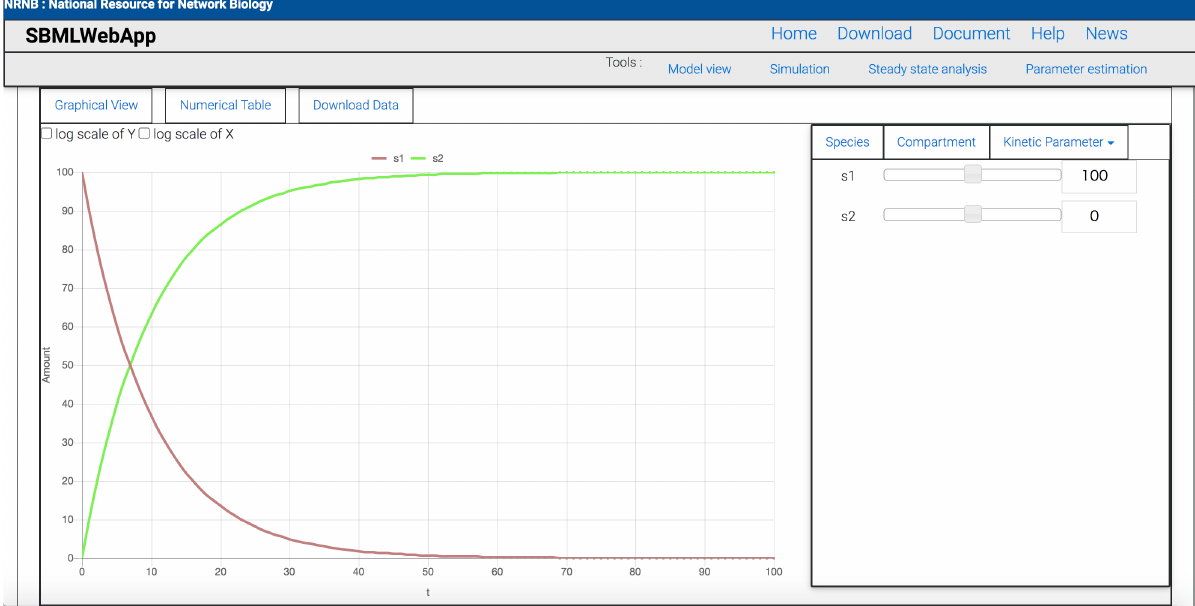
Figure 2. Results of time-course simulation analysis. The x -axis shows the time, and the y -axis indicates amounts or concentrations of species depending on which of either the SBML model defines for the respective species. Each line in the graph corresponds to the time course of a single species. The check box of “log scale of Y” and “log scale of X” allows switching between linear and logarithmic axis scales. The initial values of species, compartment sizes, and kinetic parameters can be changed via the window on the right side. When a value is changed, the simulation is executed on the fly.